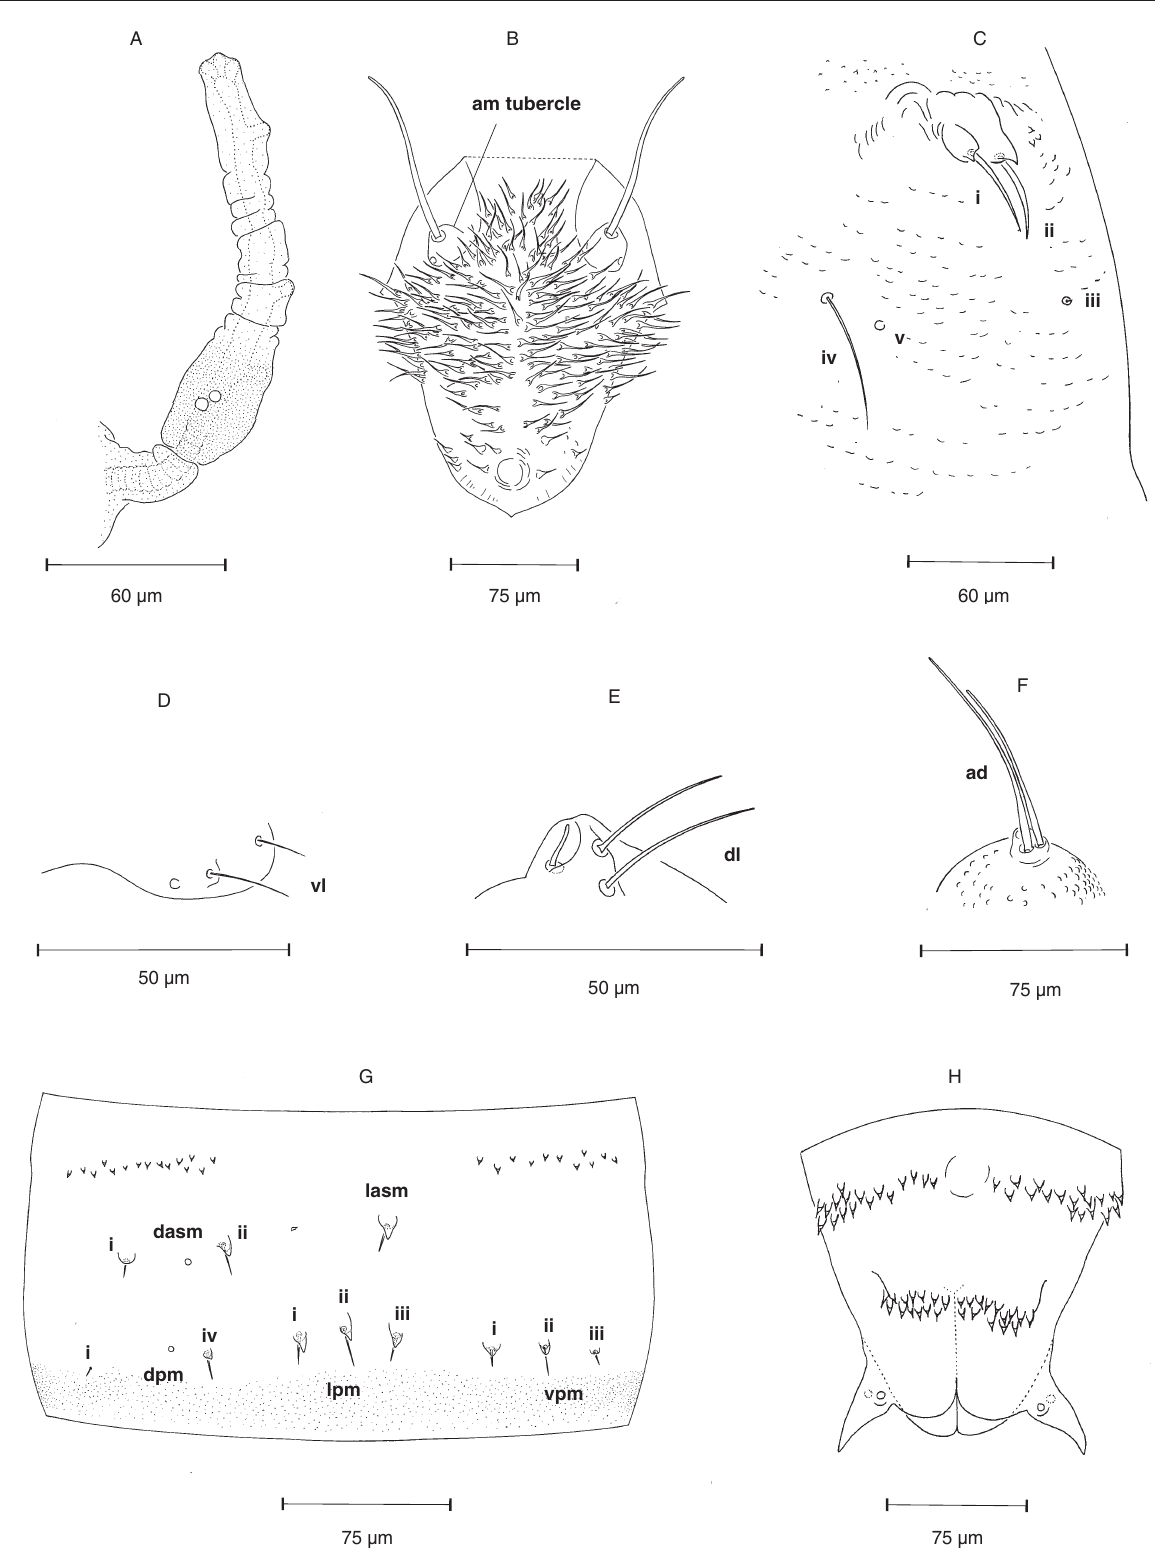
FIG. 1 The pupa of Culicoides sp. # 54 dark form: (A) prothoracic respiratory organ; (B) ♀ operculum; (C) thorax (setae d i – d v); (D) ventrolateral setae (vl); (E) dorsolateral tubercle (dl); (F) anterodorsal tubercle (ad); (G) fourth abdominal segment; (H) caudal